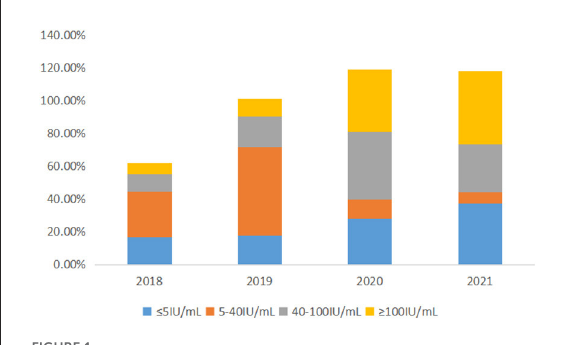
FIGURE1 Distribution of serum anti-PT IgG antibody concentrations in Jiangsu,